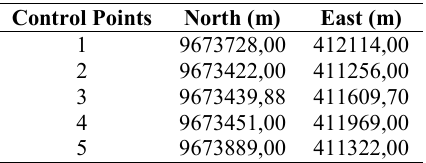
Table 3 - UTM coordinates of control points for georeferencing satellite